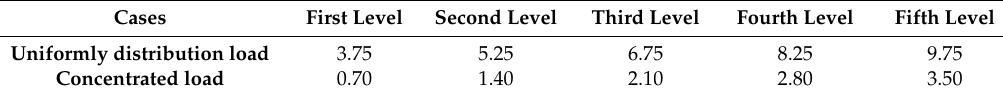
Figure 9. In-situ loading test: ( a ) Uniform loading; ( b ) Concentrated loading. Table 3. Load level in two loading cases (Unit: kN).